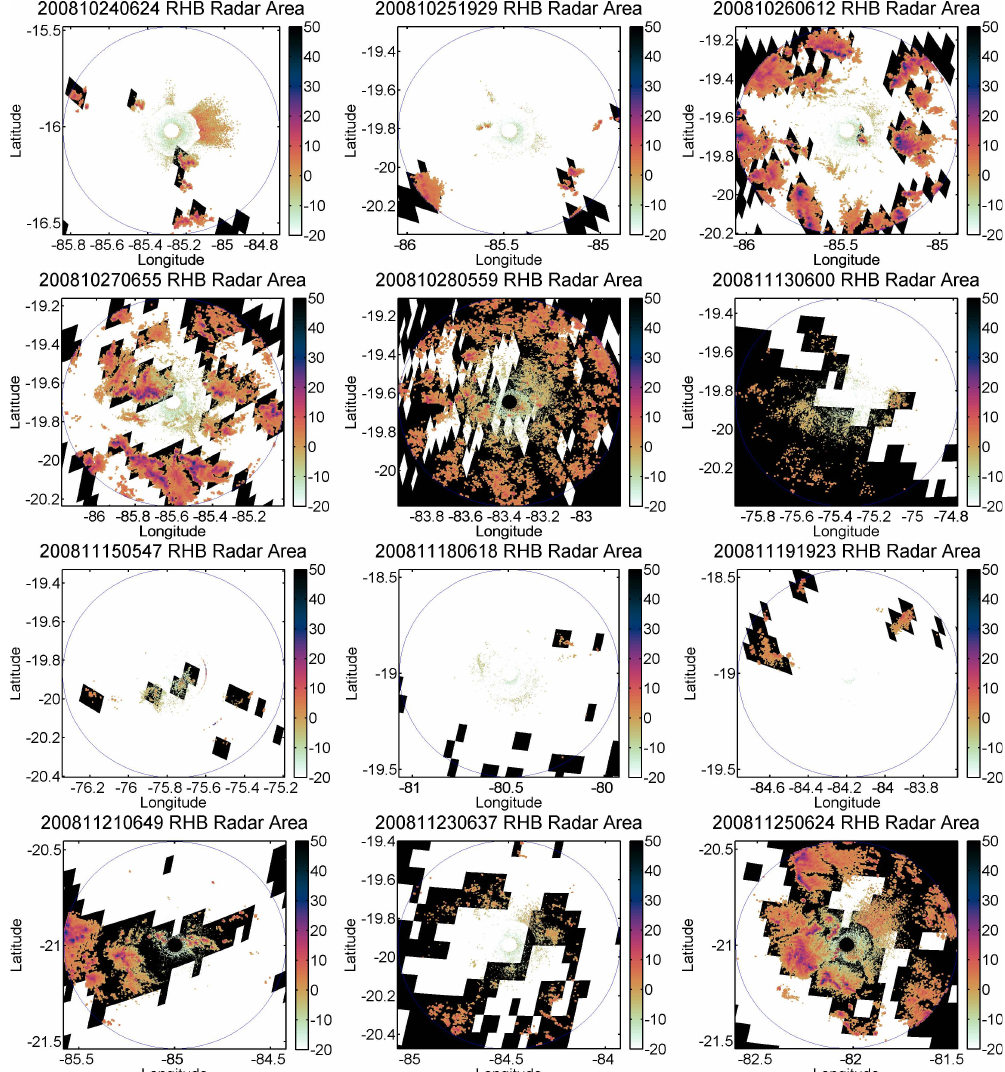
Fig. 3. C-band radar reflectivity data (dBZ) from the NOAA ship Ronald H. Brown , collected during the VOCALS project during October and November 2008, overlaid atop the 89-GHz–based binary heavy drizzle classification product. The black areas are the drizzle areas as classified by the binary heavy drizzle classification algorithm. The blue circle represents the maximum range of the